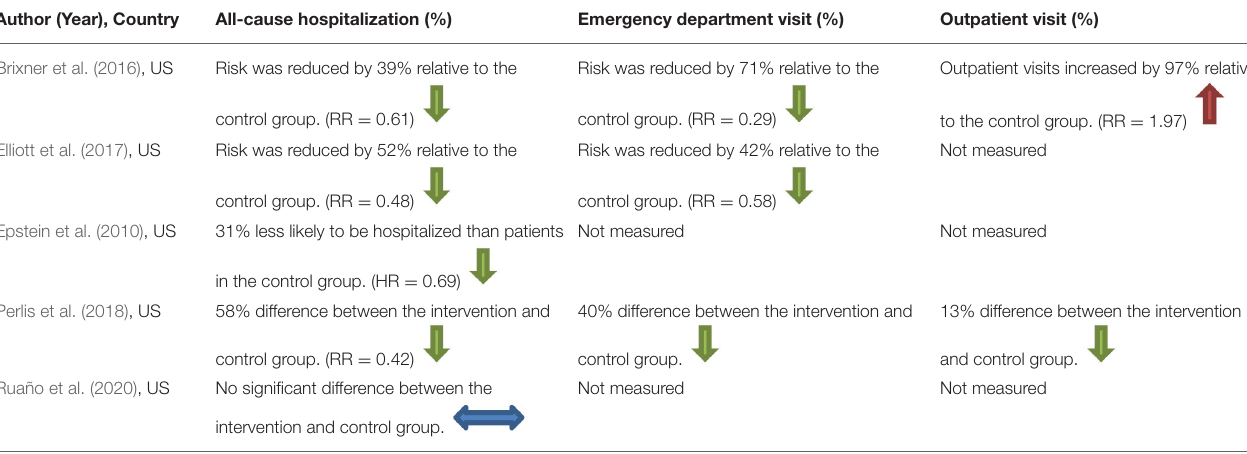
TABLE 5 | Risk of hospitalization in PGx-tested arm and control (treatment-as-usual) arm. Author (Year),